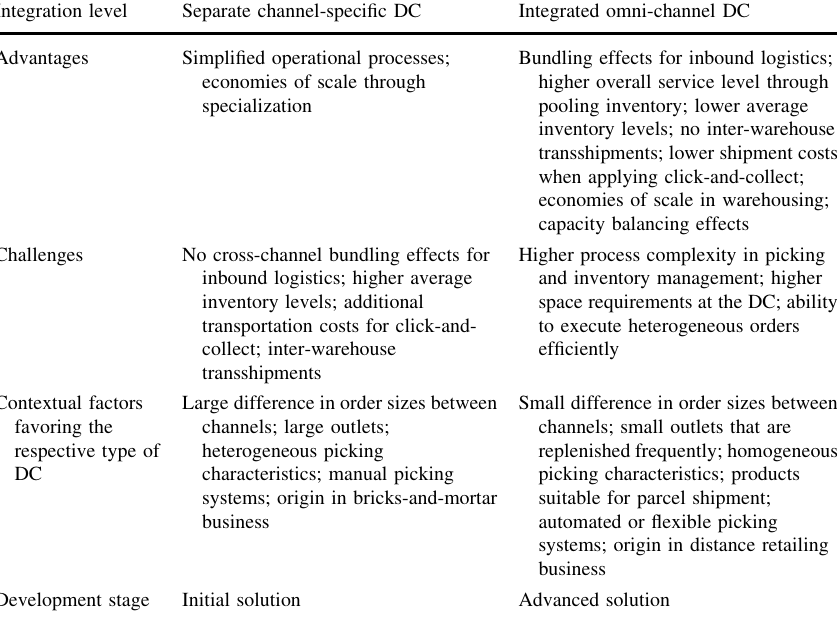
Table 1 Summary of omni-channel retailer DC integration levels Integration